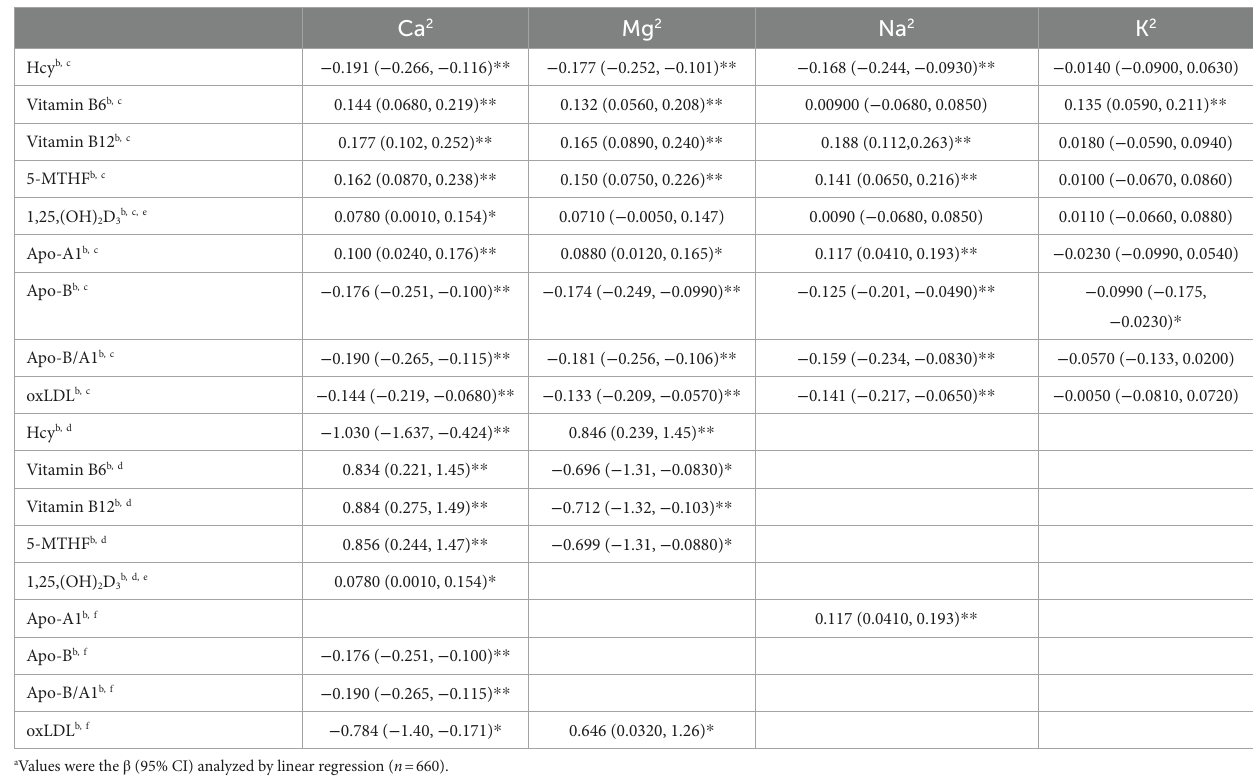
TABLE 3 Effects of mineral intake from daily drinking water on serum Hcy, lipid parameters, and related vitamines after consumption of DDW in children.